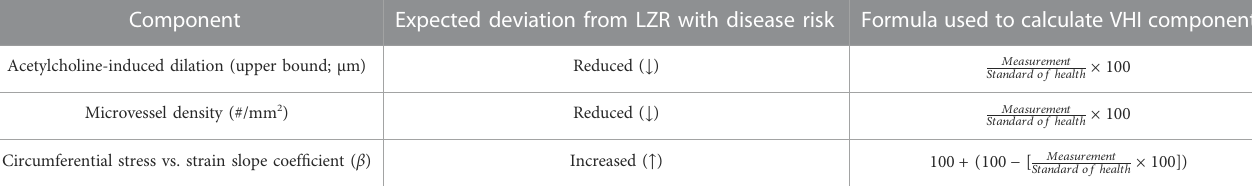
TABLE 1 Calculations used for the determination of individual VHI Components in the present study. Component Expected deviation from LZR with disease risk